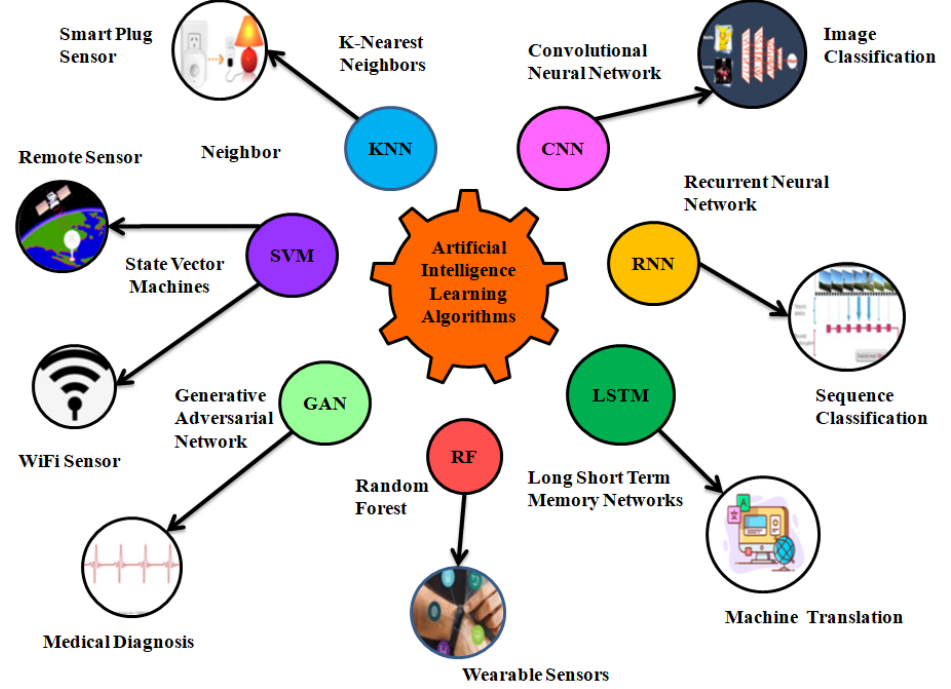
Figure 2. Various Scenarios Portraying ML and DL-based Intelligent Sensing.